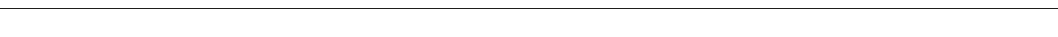
Fig. 7 Mechanistic events enabling opening of the pathway for lipid fl ip from the IC to the EC lea fl et. a Two-dimensional landscape representing mapping of all Stage 3 trajectories of the WT nhTMEM16 in POPC membrane (WT ensemble ) onto the fi rst two tICA eigenvectors (tICA 1 and tICA 2, see 'Methods' for details of tICA analysis). The location of microstates 1 – 6 that represent the translocation of the lipid through nhTMEM16 groove is denoted and the structural representation of these microstates are given in the surrounding snapshots. In these structural models, the advancing lipid is rendered in licorice (colored according to atom type), and relevant groove residues are shown in space fi ll representations and labeled (in microstates 2 and 5). Microstate denoted by * captures rare mode of protein – lipid interaction in which the hydrocarbon tail of a lipid inserts into the EC side of the groove interfering with the translocation of the advancing lipid (see also Supplementary Figure 10c). b Sequence of mechanistic events leading to the lipid fl ip. c Structural characteristics of the selected six microstates. The columns from left to right record the probability distributions of Z-directional distance between the phosphorus atom of the translocated lipid and the C α atom of R432 (the 0 on the x -axis represents position of the lipid with its phosphorus atom aligned in the Z direction with the C α atom of R432), of lipid tilt angle, of minimum distance between T333 and Y439, and of opening between the EC ends of TM3 and TM6 helices measured as the distance between the center-of-masses of two groups: C α atoms of residues 315 to 318 on TM3, and C α atoms of residues 432 to 435 on